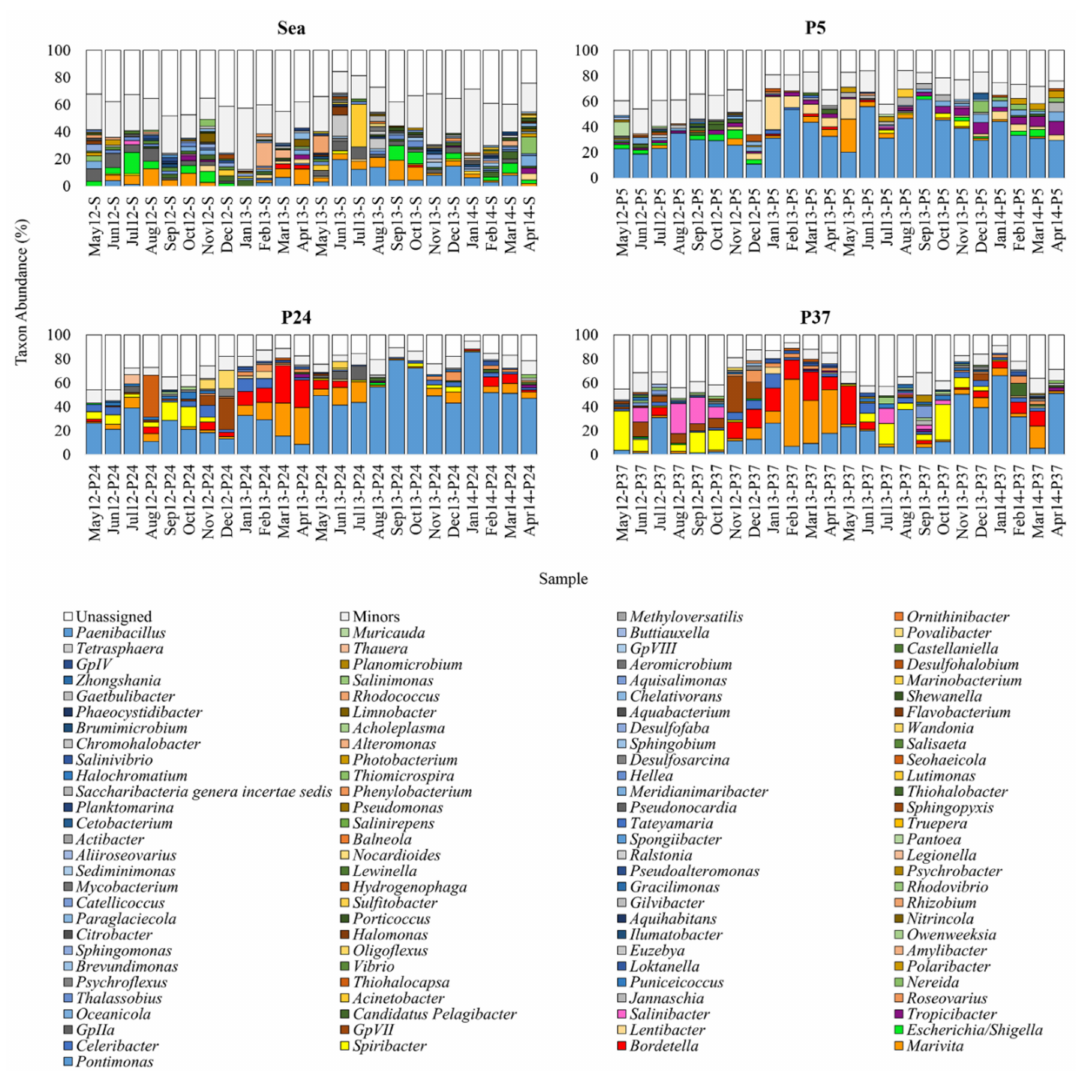
Figure 2. Bacterial composition of the ST samples at the Genus-level. Distribution of the major genera (Ra ≥ 1% in at least one sample); genera with Ra < 1% were gathered in